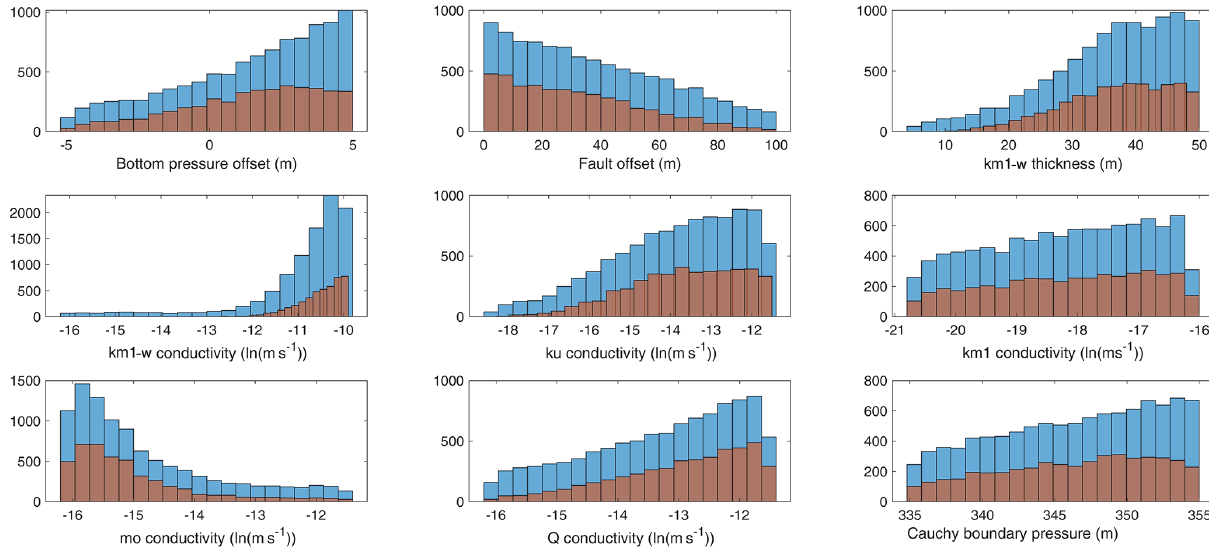
Figure 3. Marginal posterior distributions of the parameters influenced by the adaptive sampling. Blue bars show the sampled posterior, and red bars show the constrained posterior sample used in the sensitivity analysis.